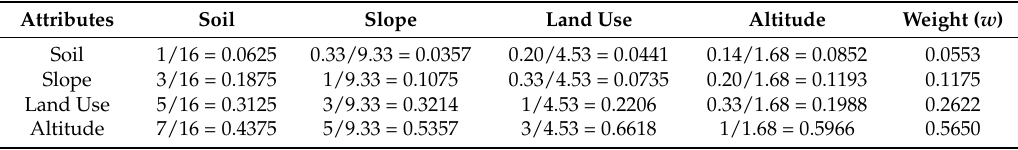
Table 4. AHP to obtain the attribute weights. The values under the heading of each attribute represent b ij scores calculated by Equation (1). In these columns, the nominator values to the left of the equal sign are a ij scores transported from Table 3, while the corresponding denominator values represent the sum of nominator values. The attribute weights ( w ) are depicted in the last column. They result from application of Equation (2) to the b ij scores calculated